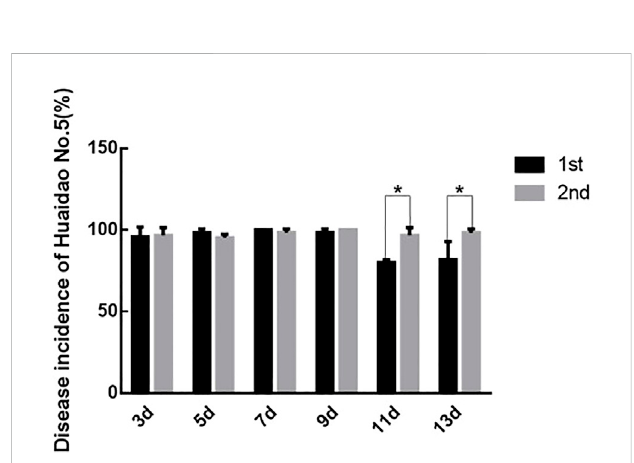
FIGURE 4 Comparison of DIs between the two inoculations. The asterisks abovethecolumnsrepresentstatisticalsigni fi cancebetweentreatments according to Duncan ’ s multiple tests; p <